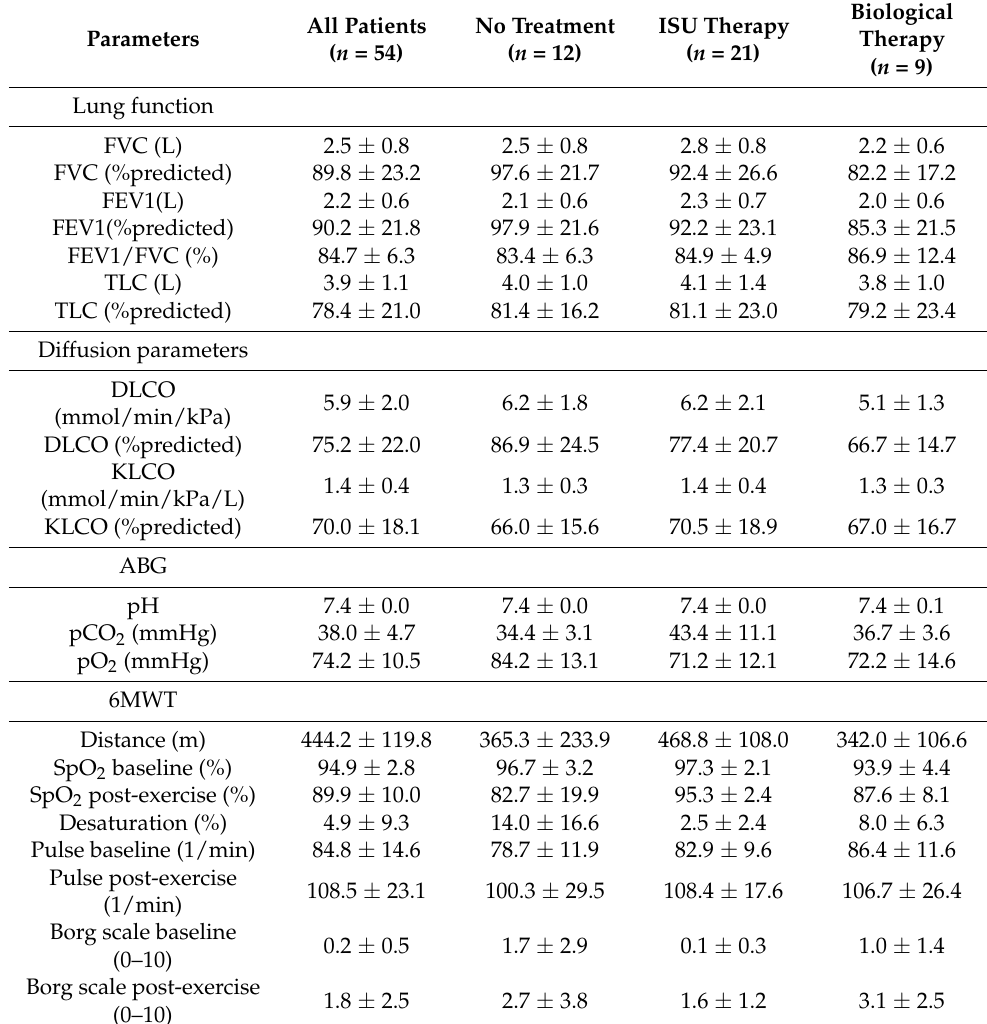
Table 2. Lung function, ABG and 6MWT functional